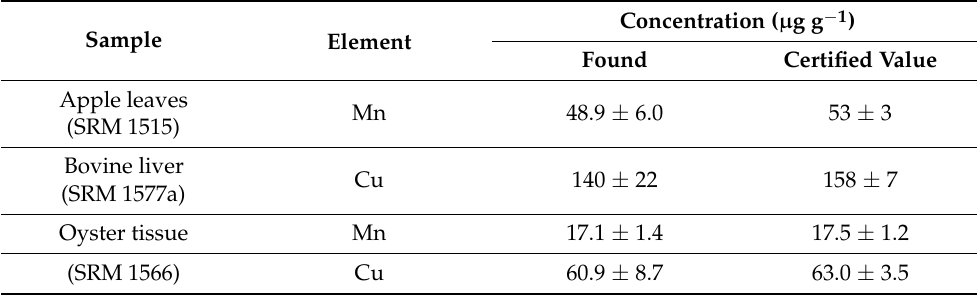
Table 2. Direct determination of Mn and Cu in biological materials by